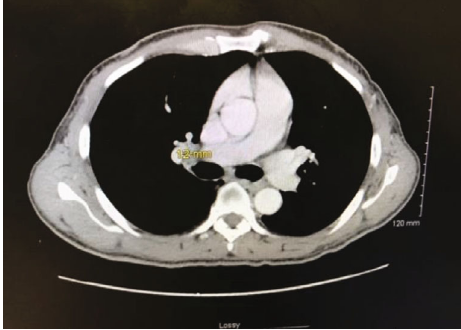
Figure 4: CT chest with contrast imaging of right hilar mass.